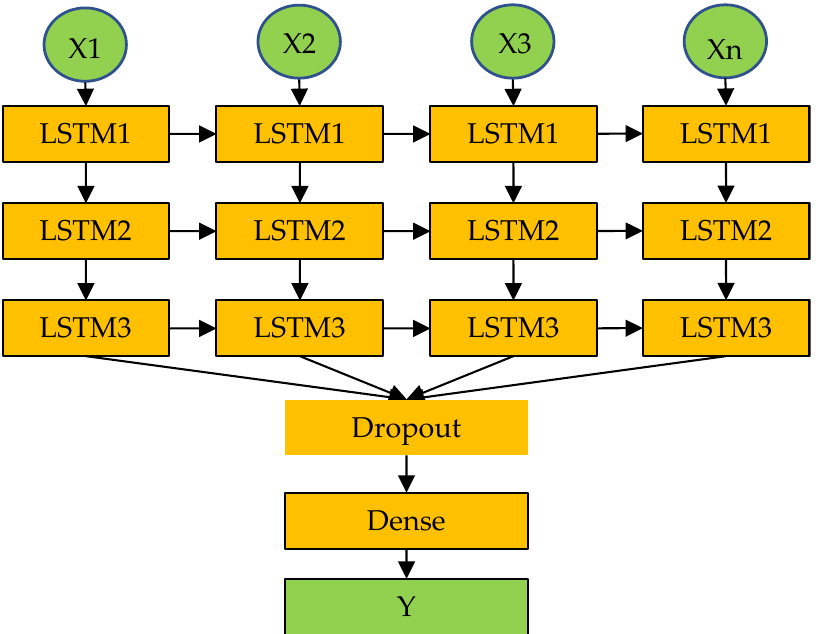
Figure 4. Deep-LSTM neural network memory architecture.